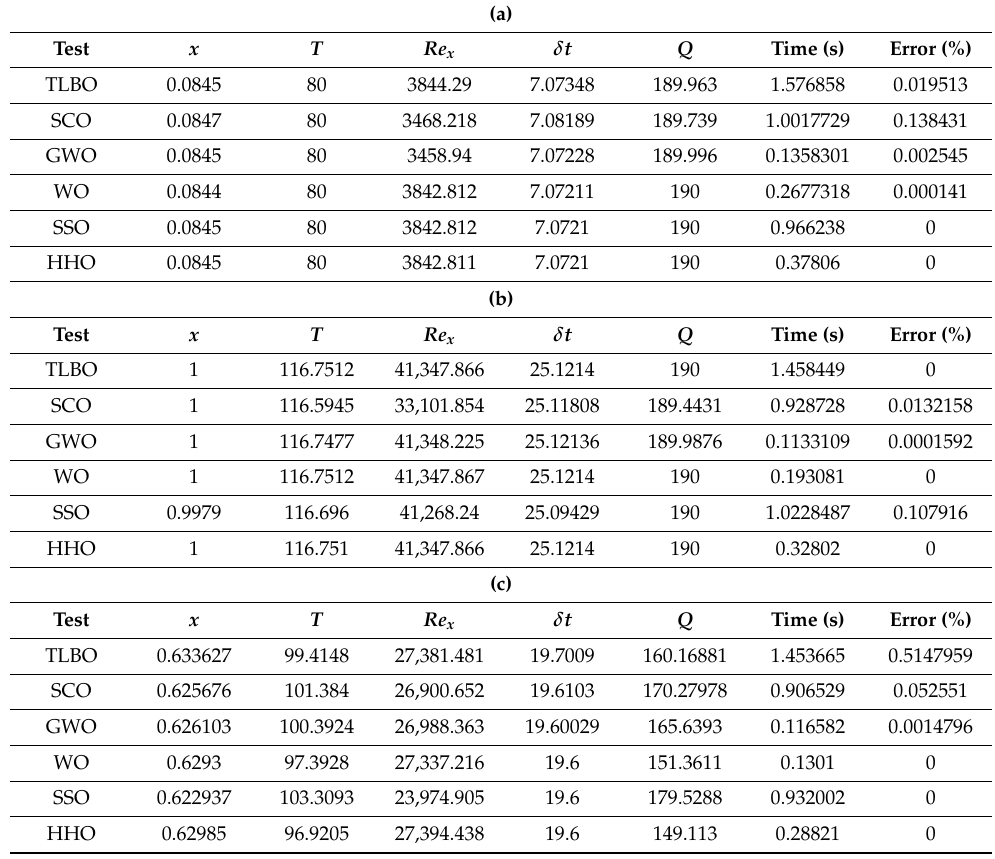
Table 4. Case 3 optimization results, ( a ) δ t Minimum value, ( b ) δ t Maximum value, ( c ) δ t Target value (19.6 mm).